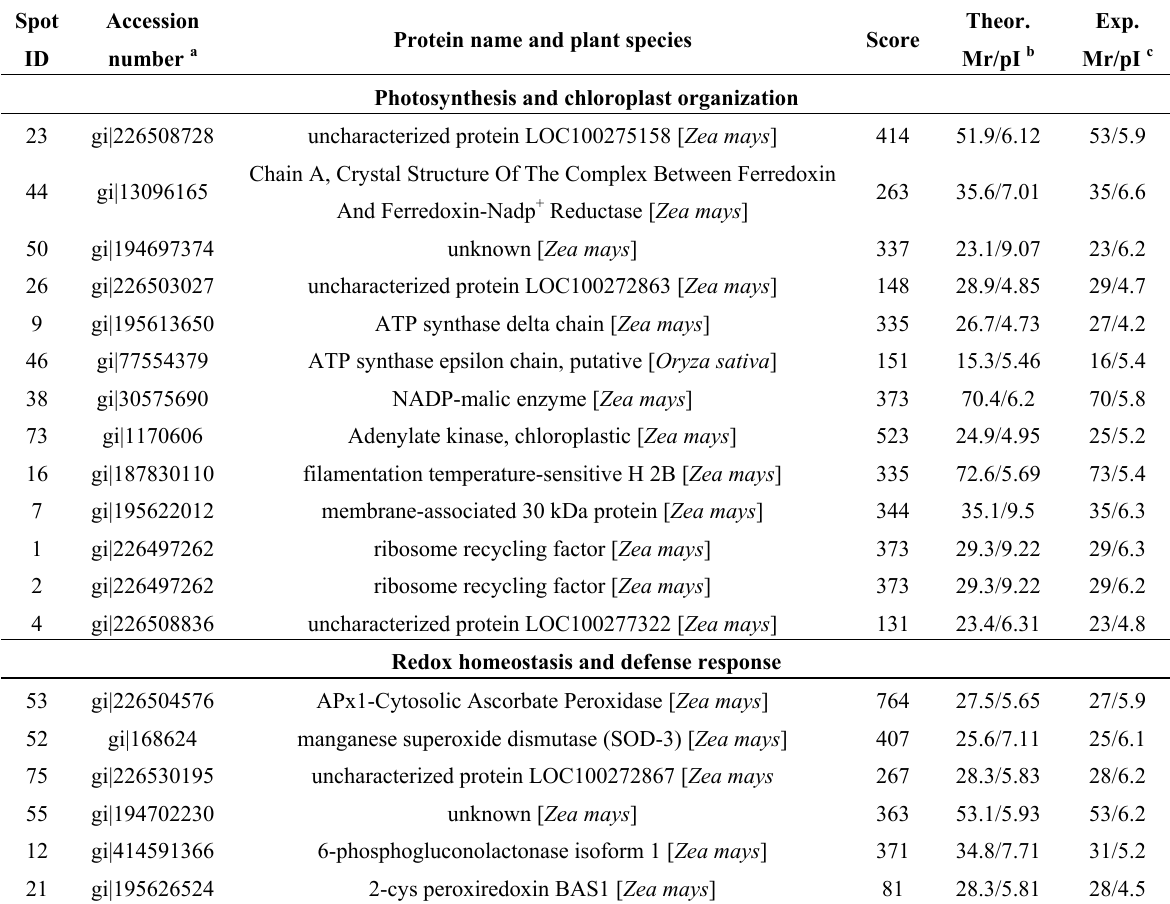
Table 1. Differentially expressed proteins under Cr stress conditions in maize leaves identified by MS